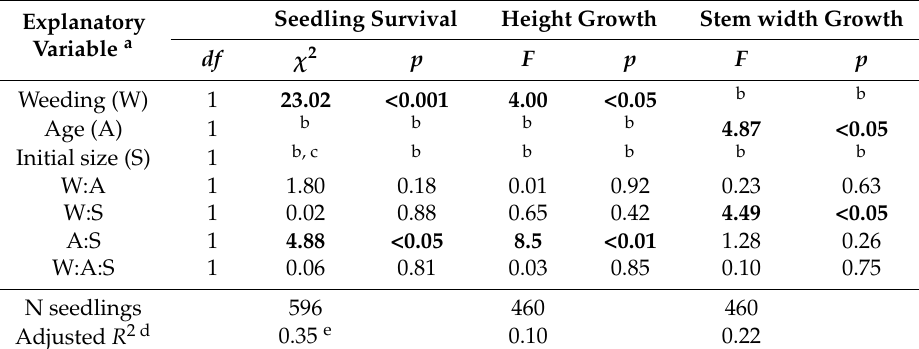
Table 2. Statistical results.